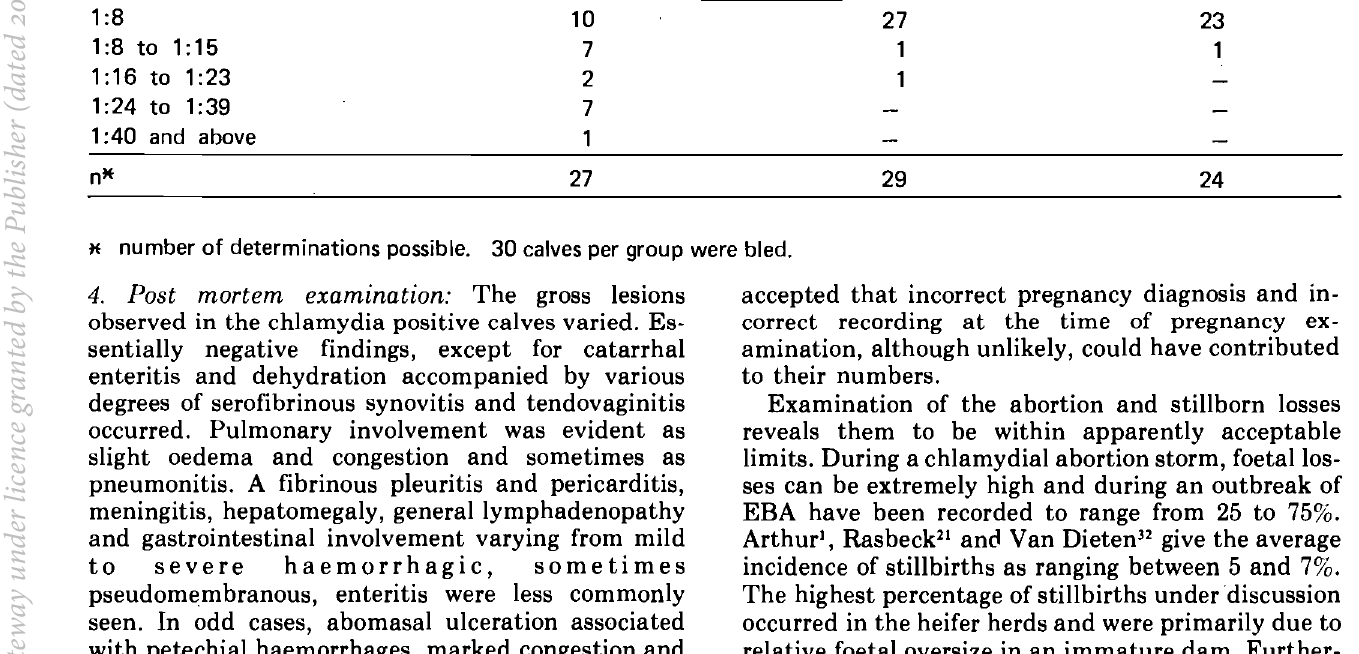
Table 10: CHLAMYDIAL ANTIBODY LEVELS OF THREE CALF GROUPS FROM SECTION'S', FARM 2, 1972 Antibody